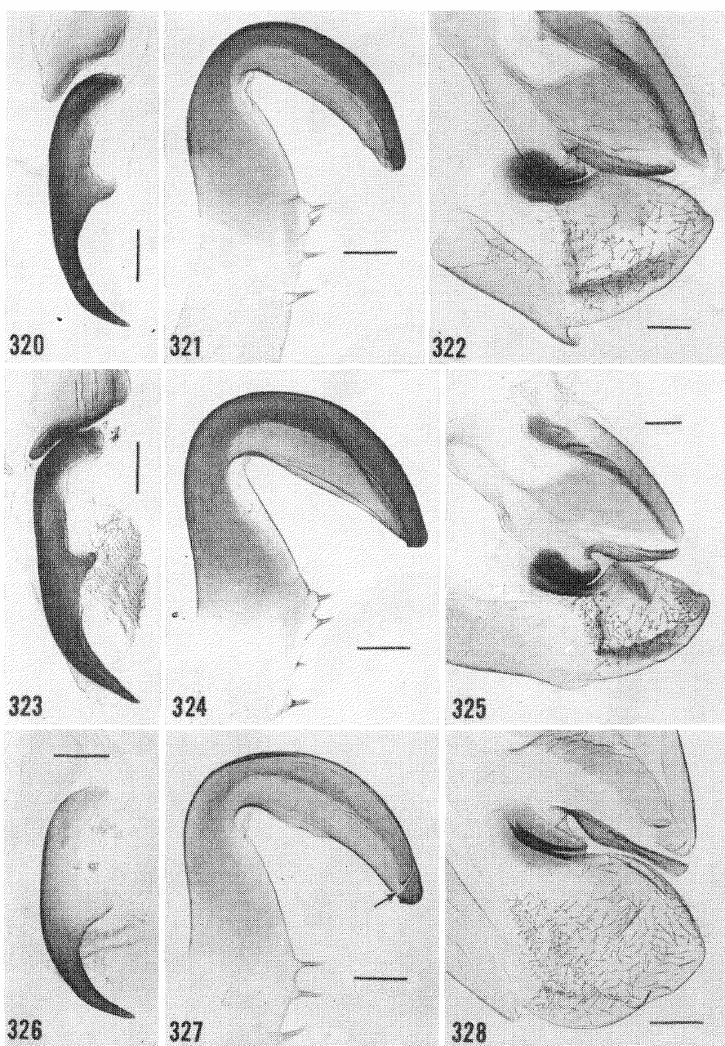
Figs. 320-328. Cockroach male genitalia. 320-328. Elilampra sodalis. 320-322. (92 ANSP). St. Jean du Maroni, French Guiana (Paratype ot E. cinnamomea Hebard). 323-325. (48 USNM). Surinam (det. Roth). 326- 328. (88 ANSP). Parfi, Brazil (det. Rehn; arrow in Fig. 327 points to a thin line representing the subapieal incision). (scale